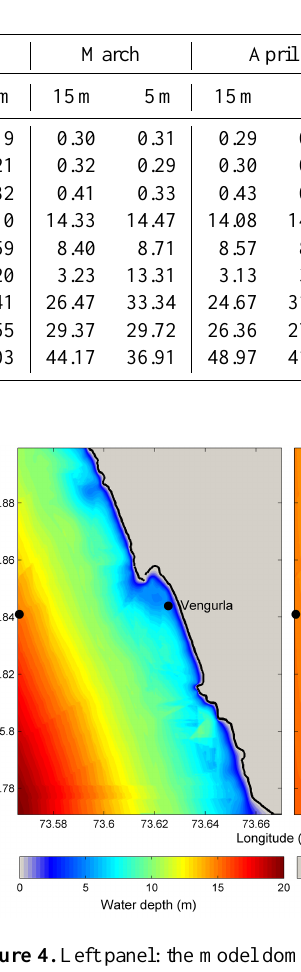
Table 2. Average value of wave parameters of long-period (LP), intermediate-period (IP) and short-period (SP) waves at 15 and 5m water depth in different months.